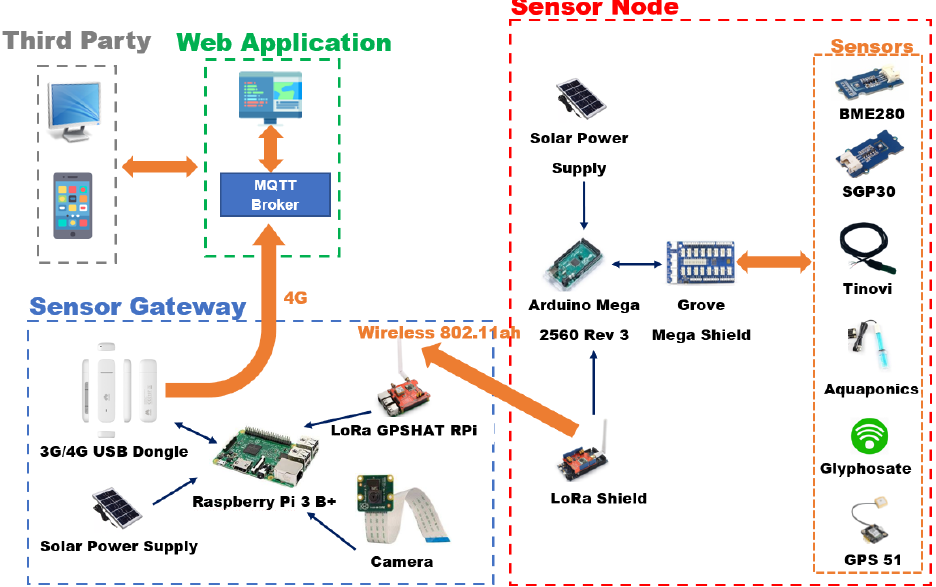
Figure 1. Simplified architecture diagram of the proposed device.